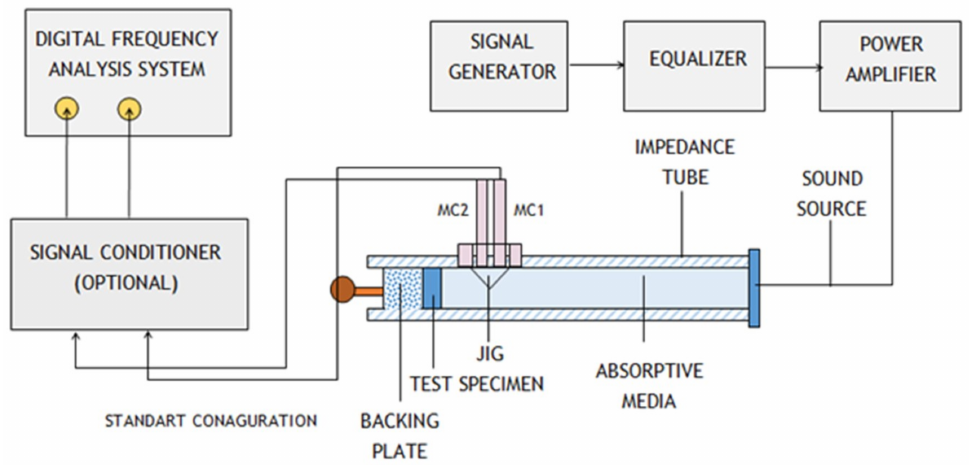
Figure 1. Configuration of impedance tube test refers to ASTM E 1050-98 [28]. Test sample of Shell Fiber Reinforced Polyester